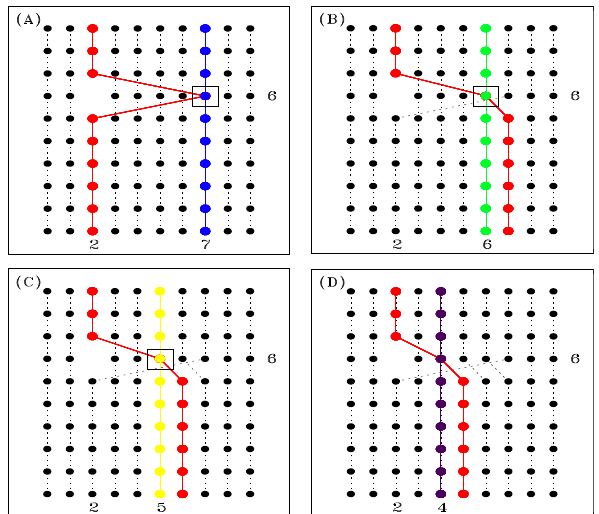
Fig. 5. Simple scheme that explains how a driving of δ + =5 can generate in an otherwise unperturbed strands an avalanche last- Fig. 5.— Simple scheme that explains how a driving of δ + = 5 can generate in an otherwise Fig. 5.— Simple scheme that explains how a driving of δ + = 5 can generate in an otherwise ing at least three iterations. In panel (A) 2 [ 7 , 6 ] ∼ 2 . 75 rad then being 2 C =2 rad the node [7, 6] is unstable so the redistribution unperturbed strands an avalanche lasting at least three iterations. In (A) Θ [7 , 6] ∼ 2 . 75 rad unperturbed strands an avalanche lasting at least three iterations. In (A) Θ [7 , 6] ∼ 2 . 75 rad rule is applied leading to the configuration shown in panel (B) . then being Θ C = 2rad the node [7 , 6] is unstable so the redistribution rule is applied leading then being Θ C = 2rad the node [7 , 6] is unstable so the redistribution rule is applied leading Fig. 5.— Simple scheme that explains how a driving of δ + = 5 can generate in an otherwise Fig. 5.— Simple scheme that explains how a driving of δ + = 5 can generate in an otherwise At that point [7, 6] is no longer unstable but 2 [ 6 , 6 ] ∼ 2 . 11 rad so to the configuration shown in (B). At that point [7 , 6] is no longer unstable but Θ [6 , 6] ∼ 2 . 11 to the configuration shown in (B). At that point [7 , 6] is no longer unstable but Θ [6 , 6] ∼ 2 . 11 unperturbed strands an avalanche lasting at least three iterations. In (A) Θ [7 , 6] ∼ 2 . 75 rad unperturbed strands an avalanche lasting at least three iterations. In (A) Θ [7 , 6] ∼ 2 . 75 rad redistribution goes on leading to a new unstable node [5, 6] with rad so redistribution goes on leading to a new unstable node [5 , 6] with Θ [5 , 6] ∼ 2 . 03 rad rad so redistribution goes on leading to a new unstable node [5 , 6] with Θ [5 , 6] ∼ 2 . 03 rad then being Θ C = 2rad the node [7 , 6] is unstable so the redistribution rule is applied leading then being Θ C = 2rad the node [7 , 6] is unstable so the redistribution rule is applied leading 2 [ 5 , 6 ] ∼ 2 . 03 rad forcing another redistribution step. Finally, in forcing another redistribution step. Finally, in (D) Θ [4 , 6] ∼ 1 . 892 so driving resumes. forcing another redistribution step. Finally, in (D) Θ [4 , 6] ∼ 1 . 892 so driving resumes. to the configuration shown in (B). At that point [7 , 6] is no longer unstable but Θ [6 , 6] ∼ 2 . 11 to the configuration shown in (B). At that point [7 , 6] is no longer unstable but Θ [6 , 6] ∼ 2 . 11 panel (D) 2 [ 4 , 6 ] ∼ 1 . 892 so driving resumes. rad so redistribution goes on leading to a new unstable node [5 , 6] with Θ [5 , 6] ∼ 2 . 03 rad rad so redistribution goes on leading to a new unstable node [5 , 6] with Θ [5 , 6] ∼ 2 . 03 rad forcing another redistribution step. Finally, in (D) Θ [4 , 6] ∼ 1 . 892 so driving resumes. forcing another redistribution step. Finally, in (D) Θ [4 , 6] ∼ 1 . 892 so driving resumes.